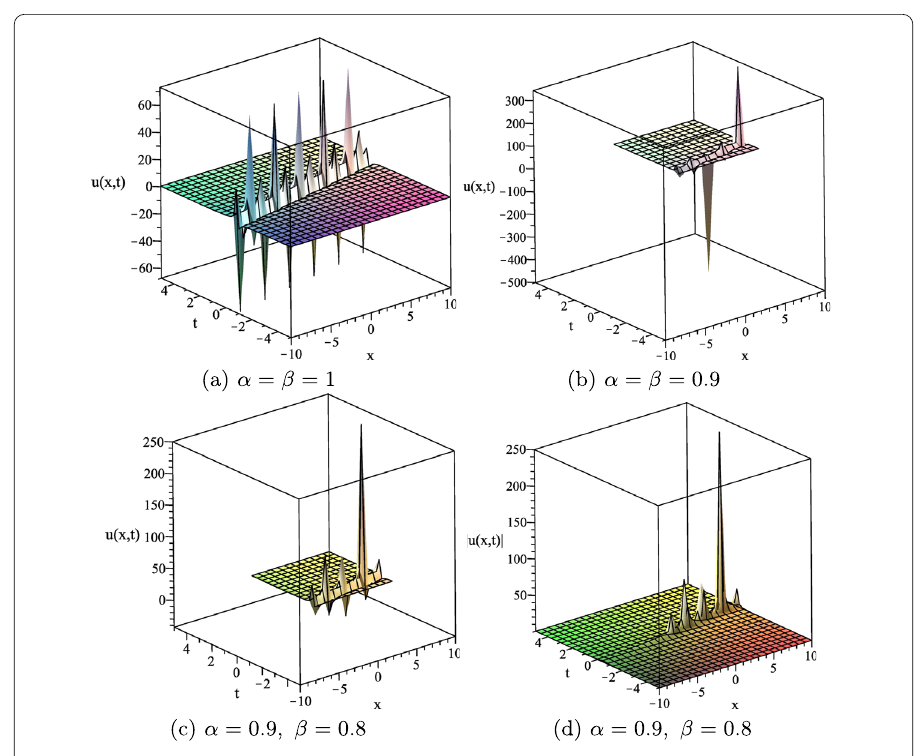
Figure 4 Associated plots of u 3 ( x , t ) in Eq. (55) of Eq. (2) on –10 ≤ x ≤ 10 and –5 ≤ t ≤ 5 using the ( G (cid:2) / G ,1/ G )-expansion method